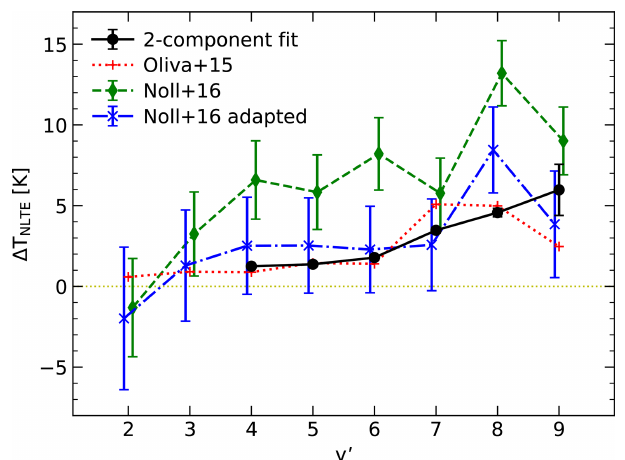
Figure 13. Estimate of non-LTE contributions to rotational temper- atures for the three lowest rotational lines with F (cid:48) = 1 as a func- tion of the upper vibrational level v (cid:48) . The differences of the T rot for the two-component fits and the related T cold shown in Fig. 12 are provided by circles and solid lines. Error bars (which are only larger than the symbols for v (cid:48) = 9) are also given. Two-component fits of OH level populations were also performed by Oliva et al. (2015) based on data from the near-infrared spectrograph GIANO at La Palma. We used their fit parameters (no errors) to calculate (cid:49)T NLTE for v (cid:48) from 2 to 9 (plus signs and dotted lines). For com- parison, the figure also indicates the estimates by Noll et al. (2016) based on X-shooter spectra from Cerro Paranal and SABER data for a similar area (diamonds and dashes). As these (cid:49)T NLTE were derived for Einstein- A coefficients from HITRAN, we recalculated the non-LTE effects using our corrected Brooke et al. (2016) coef- ficients (crosses and dot-dashed